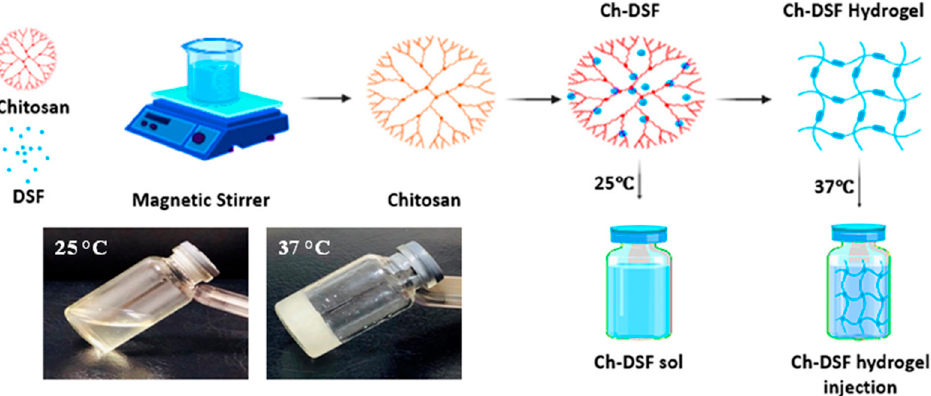
Figure 5. The schematic representation of the preparation of chitosan-based thermosensitive hydro- gels. Insert: the hydrogel at room and body temperature, adopted from open access resource [34]. DSF: disulfiram.